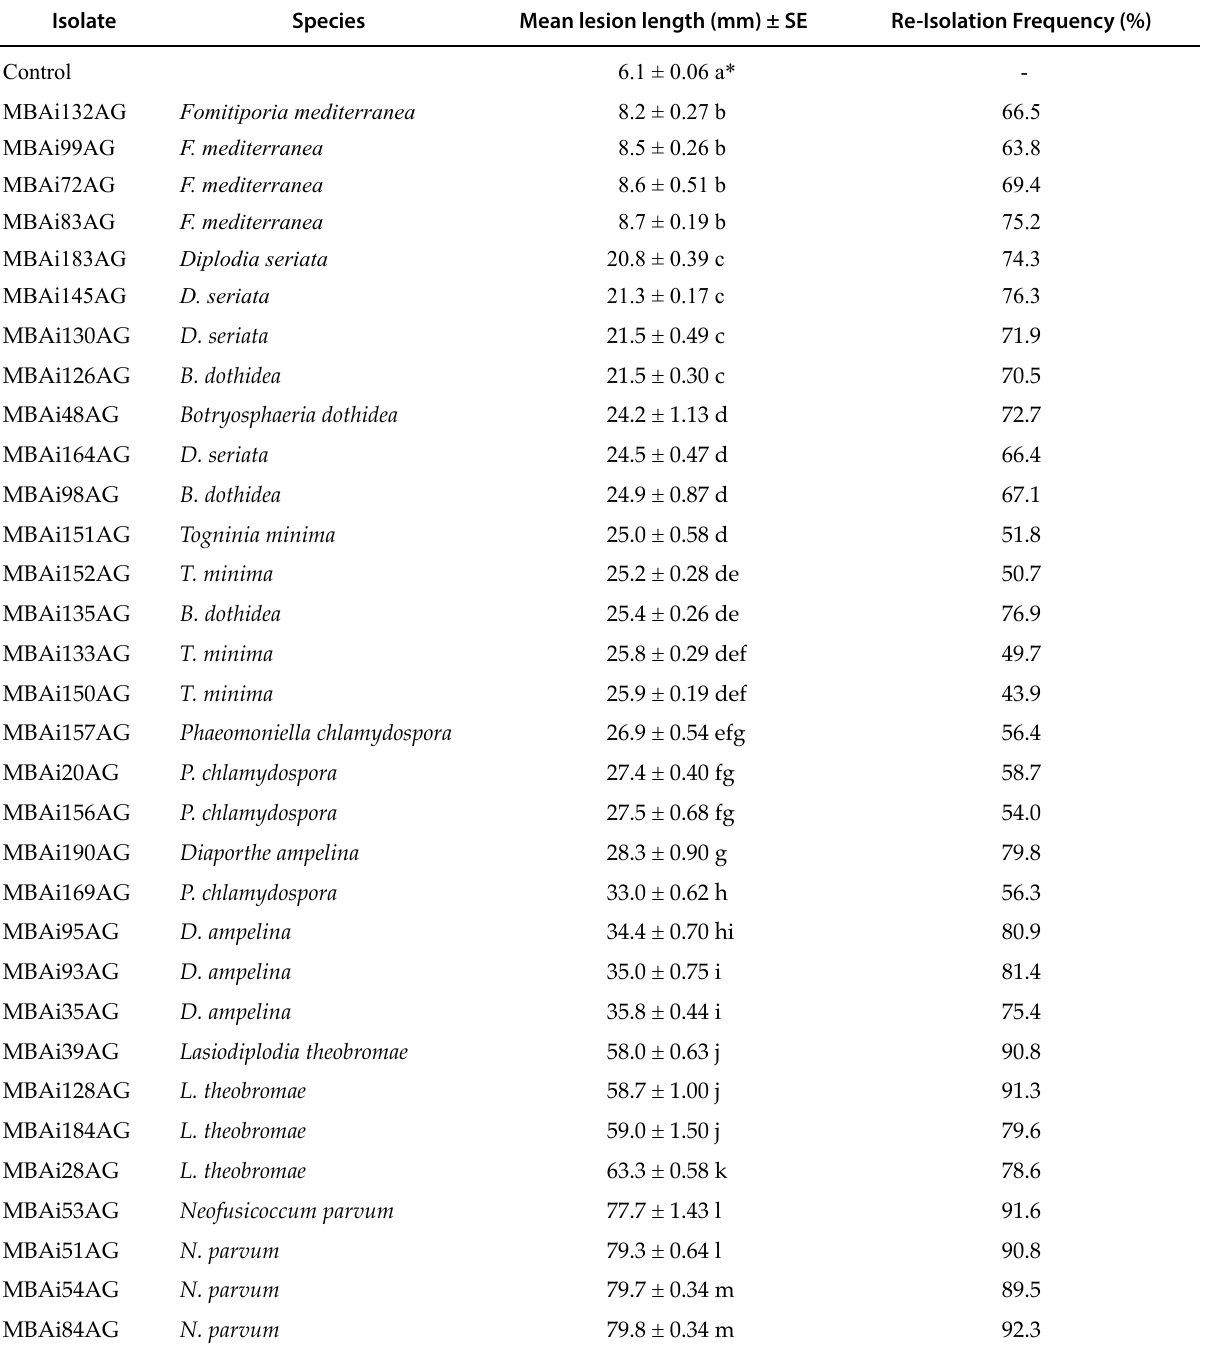
Table 4. Mean lesion length and re-isolation frequency for different fungal species on rooted grapevine.